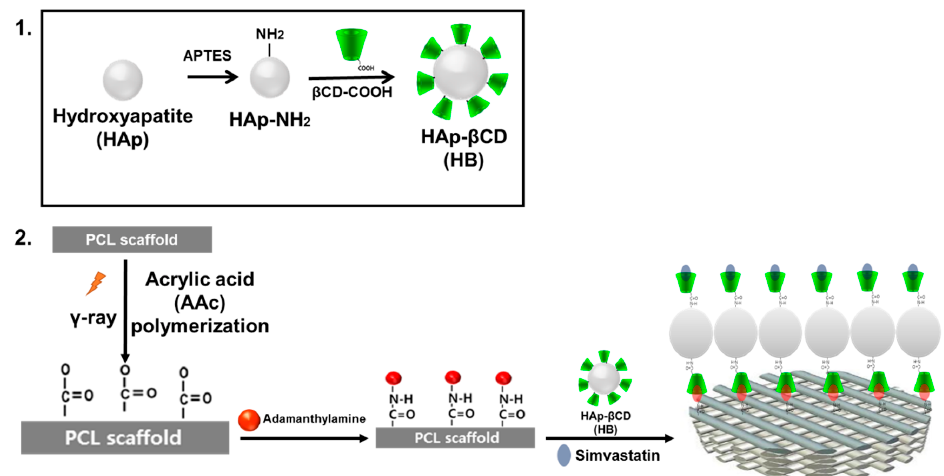
Figure 1. Schematic illustration of hydroxyapatite coated 3D poly( ɛ -caprolactone) (PCL) scaffolds. ( 1 ) Preparation of β -cyclodextrin ( β CD)-grafted hydroxyapatite (HAp) and ( 2 ) HAp coating and simvastatin loading on the surface of adamantane (AD)-modified PCL scaffold.